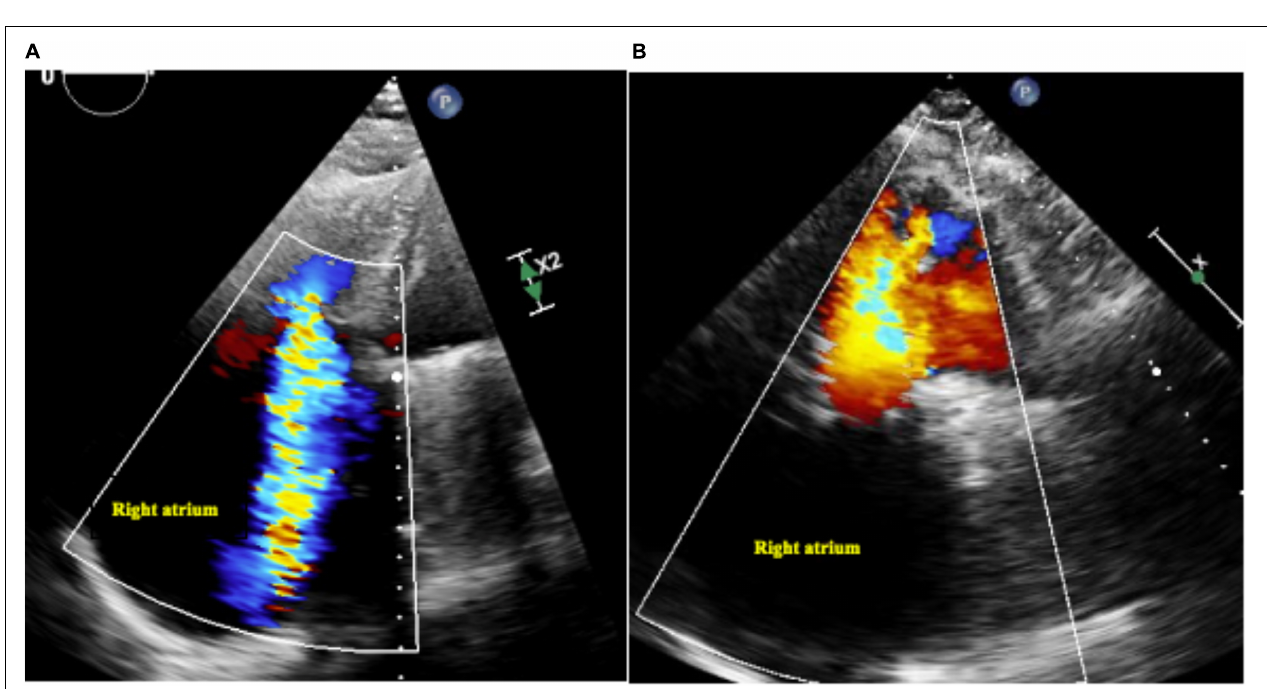
FIGURE 2 | The LuX-valve. The LuX-valve has 4 components: (1) a bovine-pericardium prosthetic tricuspid-valve pre-treated with the JeniGal anti-calcification process; (2) an umbrella disc stent made up of a self-expanding nickel-titanium alloy, for attachment to the atrial surface or tricuspid-annulus. The nickel-titanium frame is laser-cut, heat and surface treated so that it can be easily compressed, while providing adequate strength, durability and flexibility during deployment. Once the frame is deployed at the target location in the heart, it self-expands into its memorized, predesignated shape after warming to body temperature; (3) an interventricular anchorage to the septum; and (4) 2 expanded polytetrafluoroethylene-covered anchoring pins to fix the leaflets and further stabilize valve anchorage. Photo reproduction authorized by Jenscare Scientific Co., Ltd.